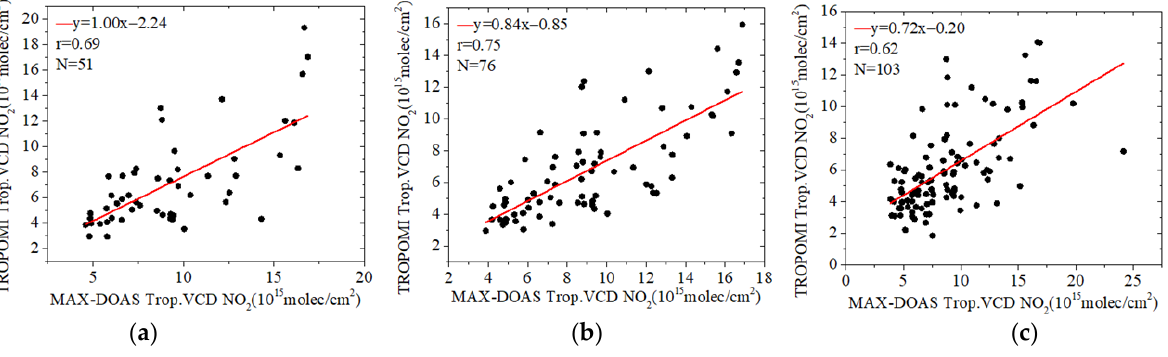
Figure 6. Comparison of the daily averaged MAX-DOAS and TROPOMI in the different matching grids in 2019 . ( a ) 0.05° grid, ( b ) 0.1° grid, and ( c ) 0.2° grid. Table 1. Comparison of the monthly averaged NO 2 measured by MAX-DOAS to TROPOMI (unit: 10 15 molec/cm 2 ).